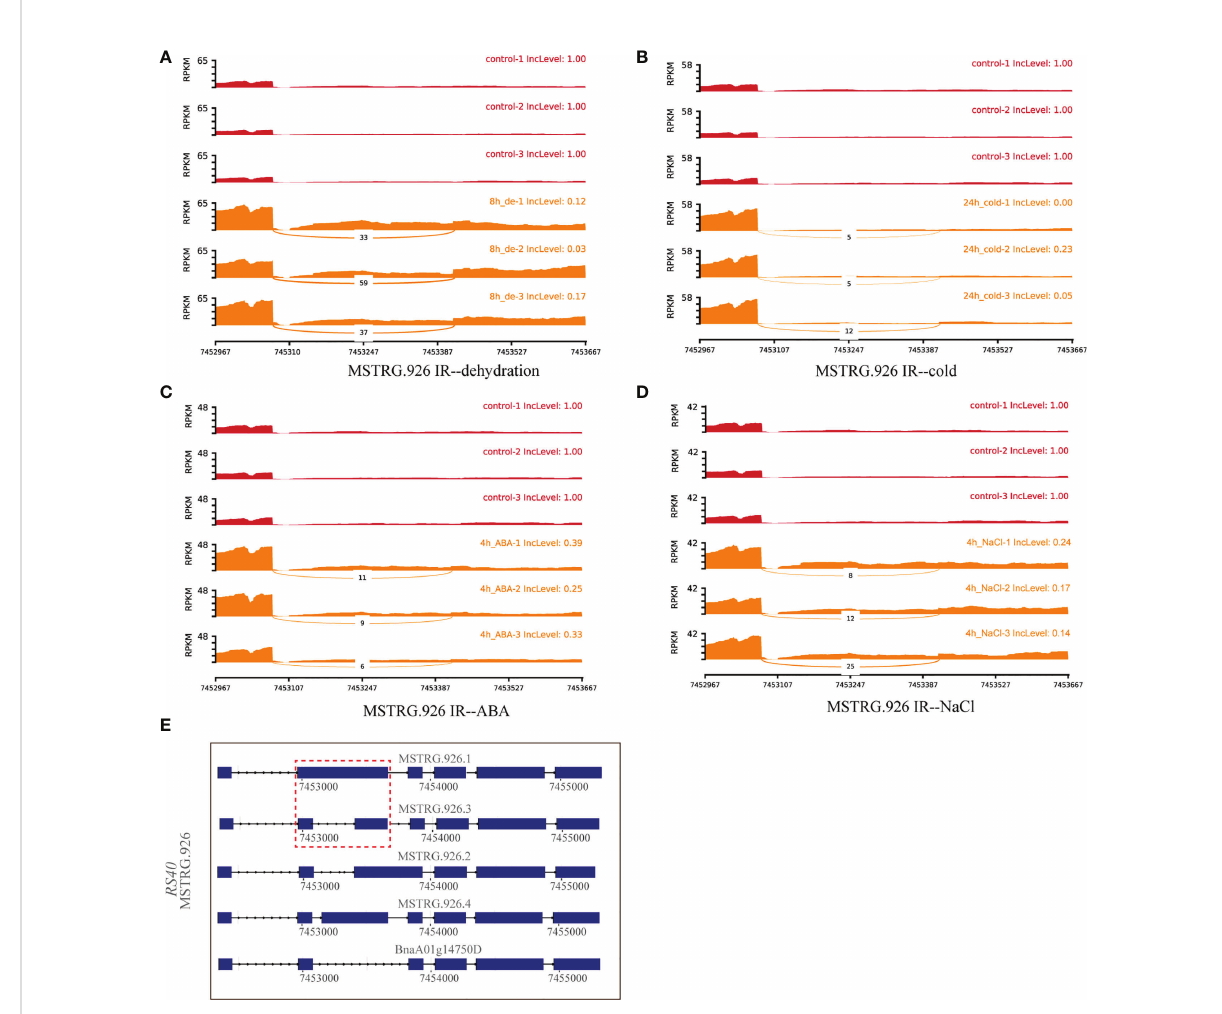
FIGURE 6 Quantitative visualization (sashimiplot) and transcripts structures of the DAS gene ( MSTRG.926 , RBP) under multiple abiotic stresses. Panels (A – D) represent dehydration, cold, ABA, and NaCl stress, respectively. The IncLevel value represents the normalized proportion of AS event. The red color denotes control, and orange color denotes treatments. Panel (E) displays the structures of all transcripts of this gene. Red dashed box indicates exons and introns shown in sashimiplots corresponding to gene structures below. The blue rectangular boxes denote the exons, the lines denote the introns, and the arrows denote the transcriptional